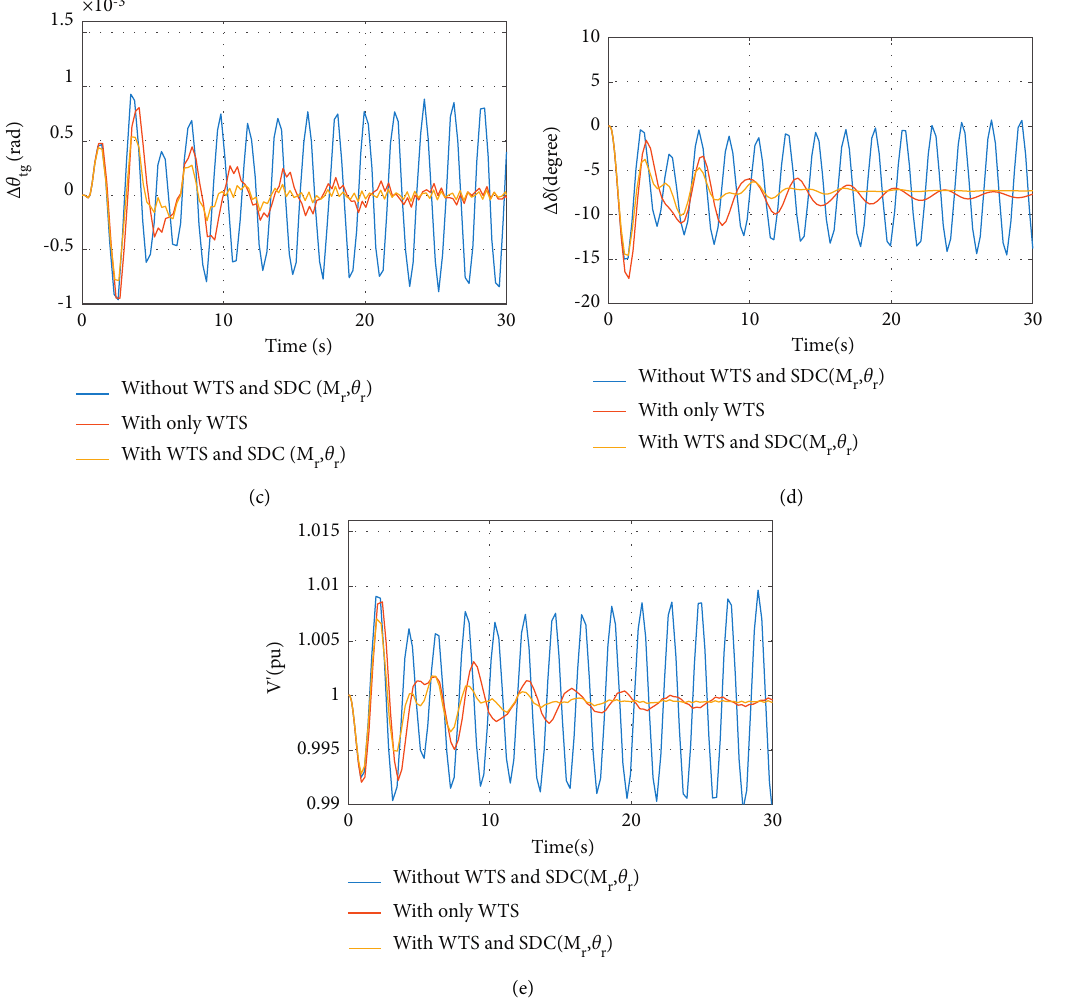
w ≈ 8m/s). (b) The rotor speed deviation in CPP (